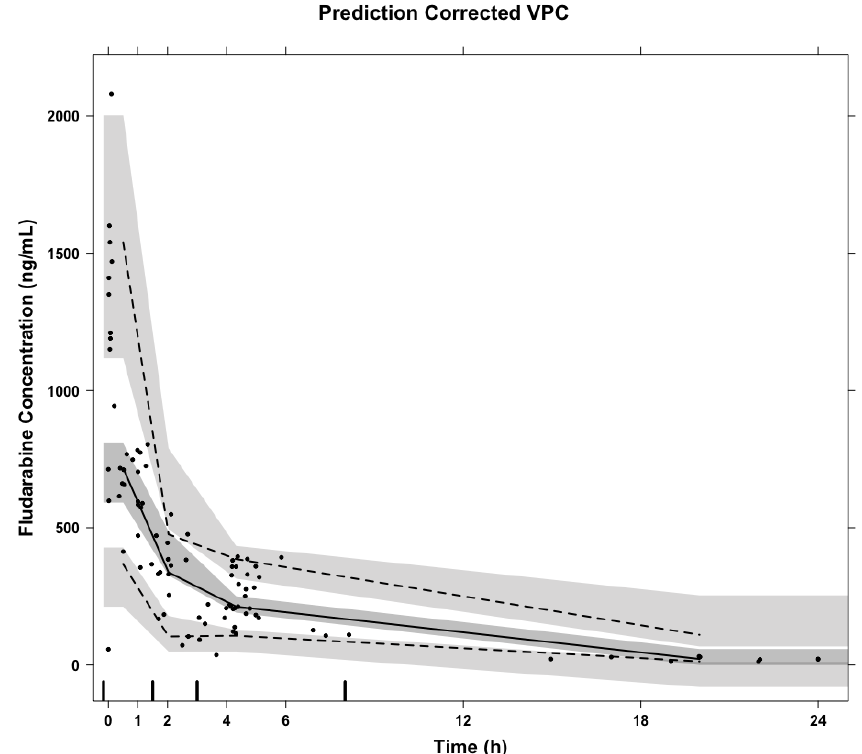
Figure 1. Prediction corrected visual predictive check of the original popPK f-ara-a concentrations (ng/mL) over time after dose (h) of the validation cohort. The solid and dashed lines represent the median, 5th, and 95th percentile of observed f-ara-a concentrations, respectively. The shaded areas represent the prediction intervals generated by the popPK model for the median, 5th, and 95th percentiles, respectively.